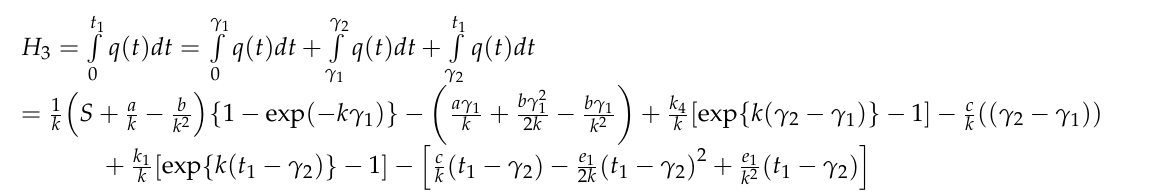
Figure 4. Pictorial representation of inventory situation under Case-III γ 2 < t 1 ≤ T . The total salvage value throughout the period is The bounds of the carrying cost of the system are C hL H 3 and C hU H 3